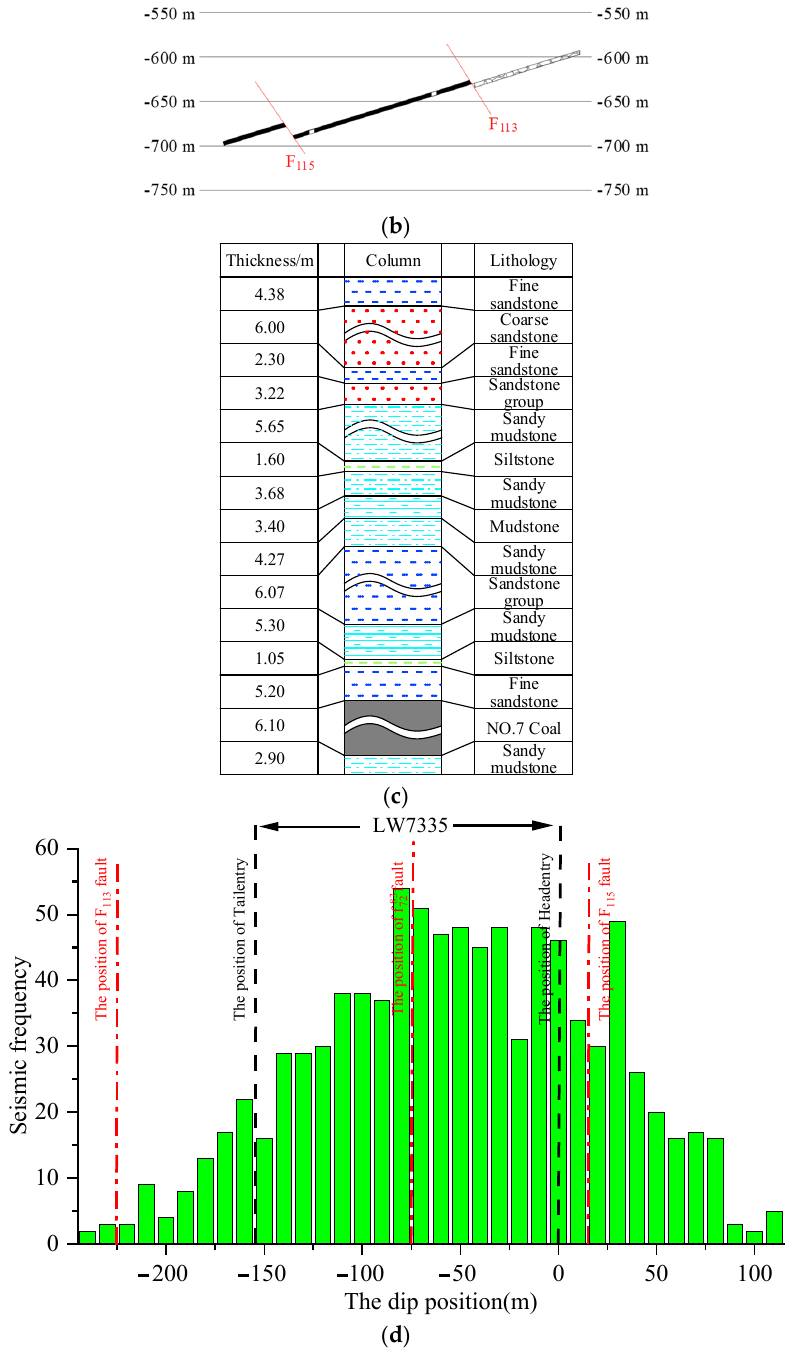
Figure 3. ( a ) Seismic events distribution of LW7335 between 2018/09/08 and 2019/01/31. ( b ) E-E cross-section of the mining coal seam in Figure 3a. ( c ) Stratigraphic column of LW7335. ( d ) The seismic events frequency distribution on the dip position of the LW7335. Green filled circles represent events with energy from 0 to 10 3 J, yellow filled circles represent events with energy from 10 3 to 10 4 J, and red filled circles represent events with energy over 10 4 J.